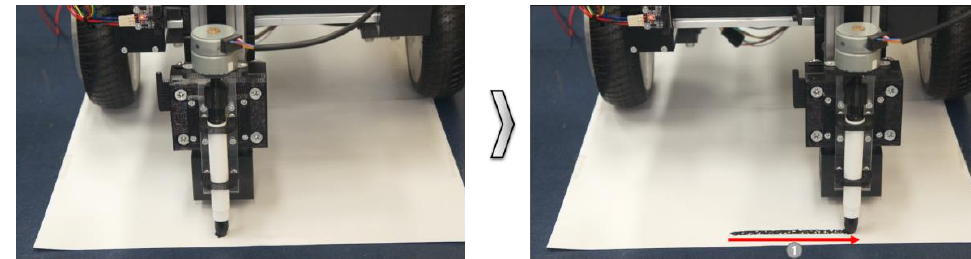
Figure 11. Before and after the y-axis movement marking functionality test.